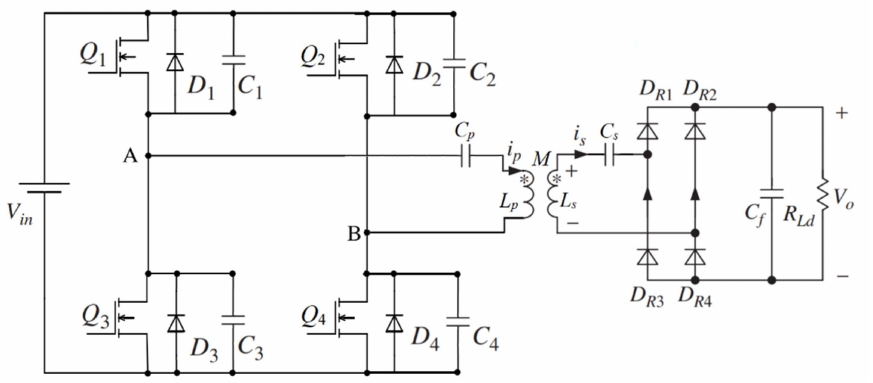
Figure 2. Topology of two-stage WPT system.